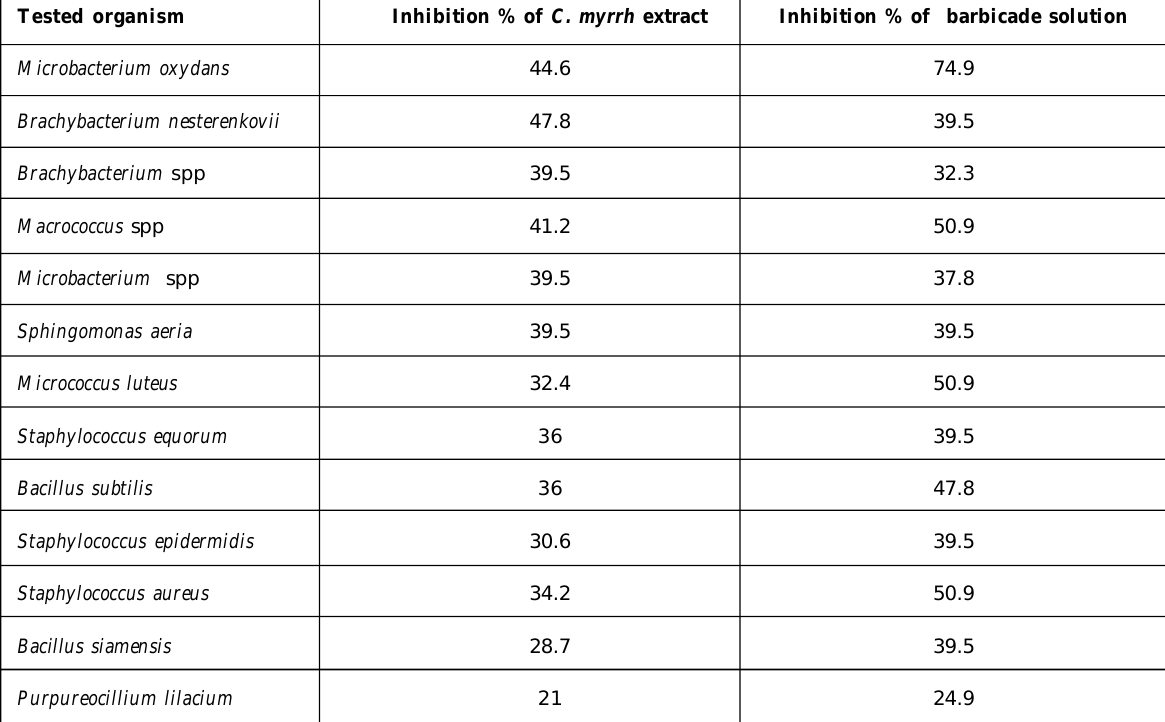
Table 8: Comparison of the effect of C. myrrh extract and barbicade solution on the inhibition of microbial Tested organism Inhibition % of C. myrrh extract Inhibition % of barbicade solution